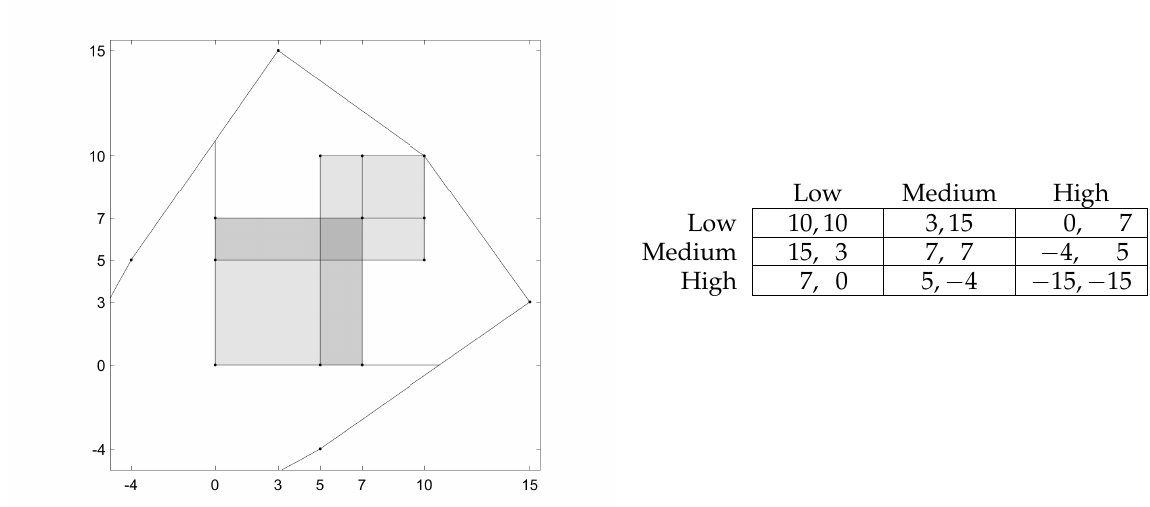
Figure 4. Four self-supporting sets in a duopoly game with three production